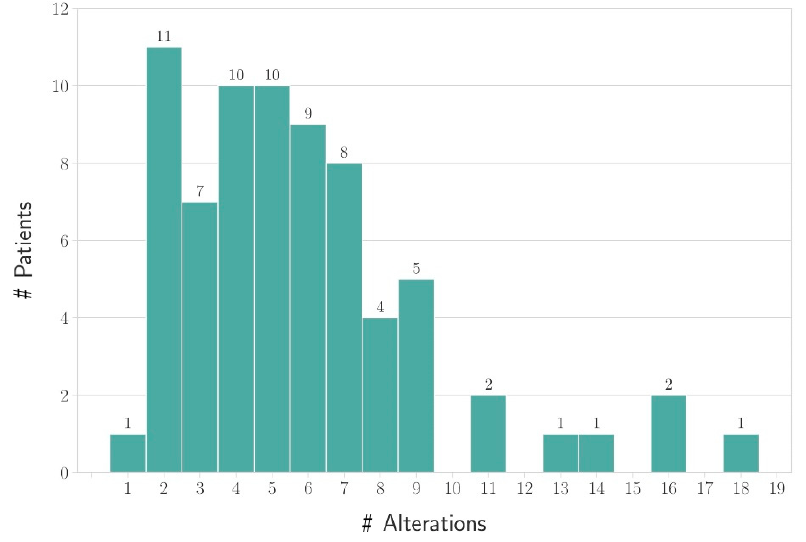
Figure 5. The number of detected alterations per patient (# indicates number of alterations).